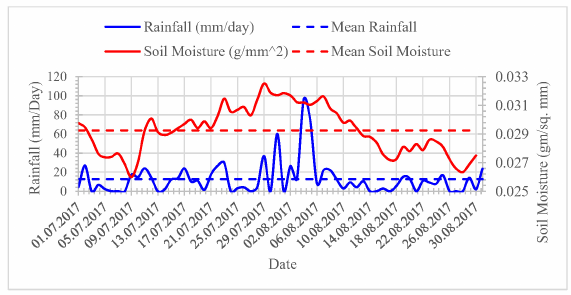
Figure 5. Variations of rainfall with soil moisture for the months of July-August 2017 This seven-day antecedent rainfall intensity prior to land- slide was 1.19 mm/hr. As already discussed, the rocks present within the vicinity of the sliding area are highly crushed and weathered. The low rainfall intensity with continuous downpour may have allowed water to percol- ate within the rock formation/slope. The percolated water may have increased pore water pressure which further re- duced the strength of the rock/soil lying between MBT and MCT thrusts. It is evident from Figure 5 that the failure of slope on 13 August 2017 could be a consequence of unprecedented rainfall occurred 5-7 days prior to land-